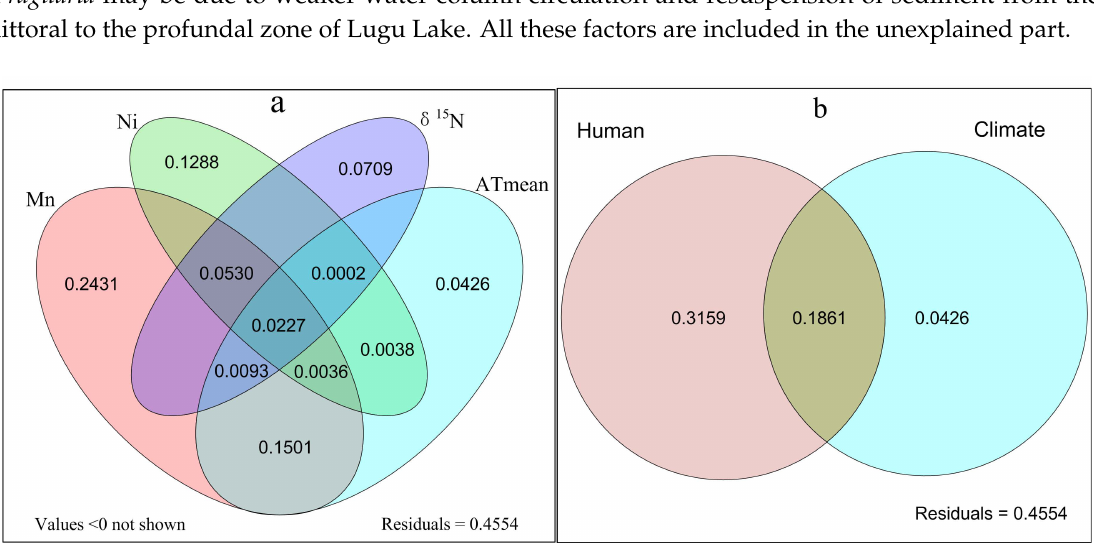
Figure 6. Plot of the variation partitioning analysis for diatom assemblages (during ca., 1951–2010 AD). ( a ) The four long ellipses from left to right represent effects of Mn, Ni, δ 15 N and annual temperature (ATmean) respectively, and the cross section represents co-influence. Residuals are the unexplained part. ( b ) The left red circle represents human impact independently, the right green circle represents climate impact independently, and the cross section represents co-influence. Residuals are the unexplained